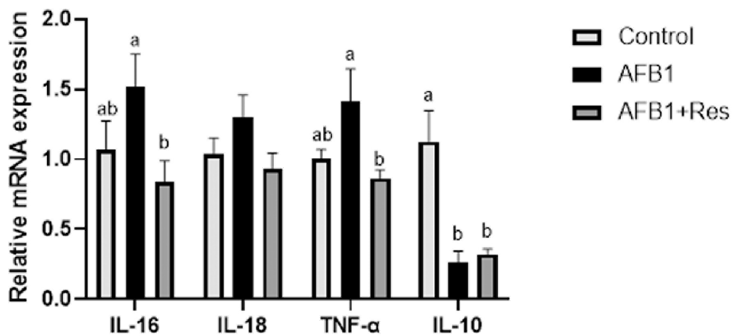
Figure 7. Effect of Res on the expression of inflammatory factor genes in duck liver exposed to AFB1. Values are represented as the mean ± SEM ( n = 6). a,b Mean values with same superscript letters or no letters within a row were of no significant difference ( p > 0.05), those with different superscript letters were of significant or extreme significant difference ( p <